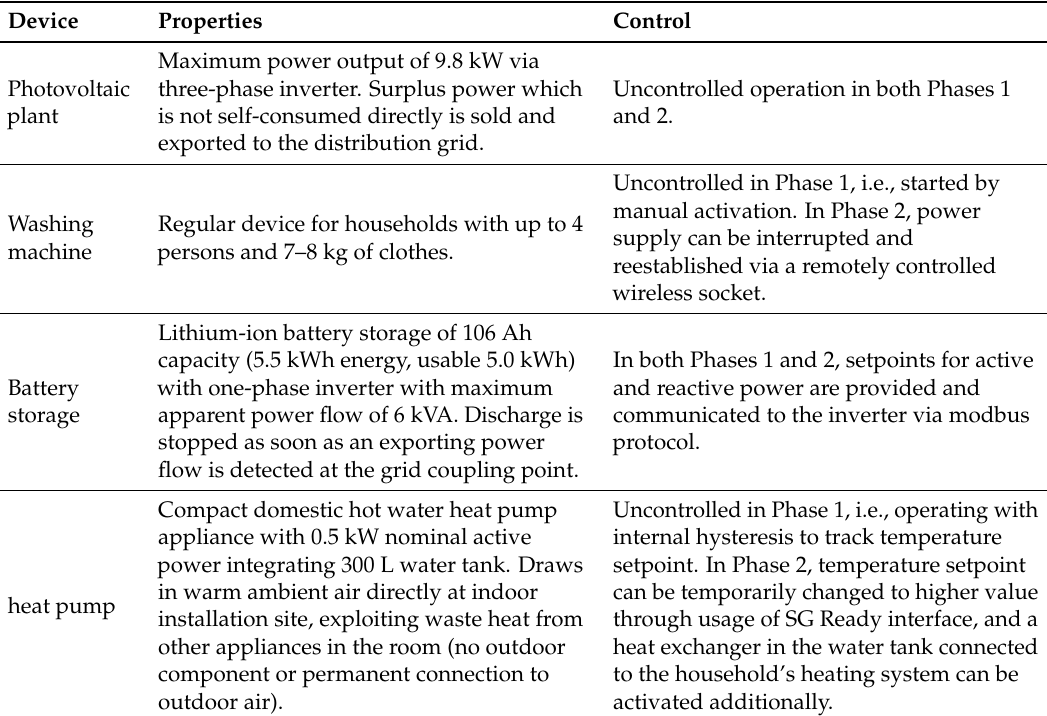
Table 1. Overview of properties of the main devices on the the demonstration site. The term ‘uncontrolled’ as used in this table refers to a situation where a device is not controlled by the smart energy system, but it might still follow an internal control